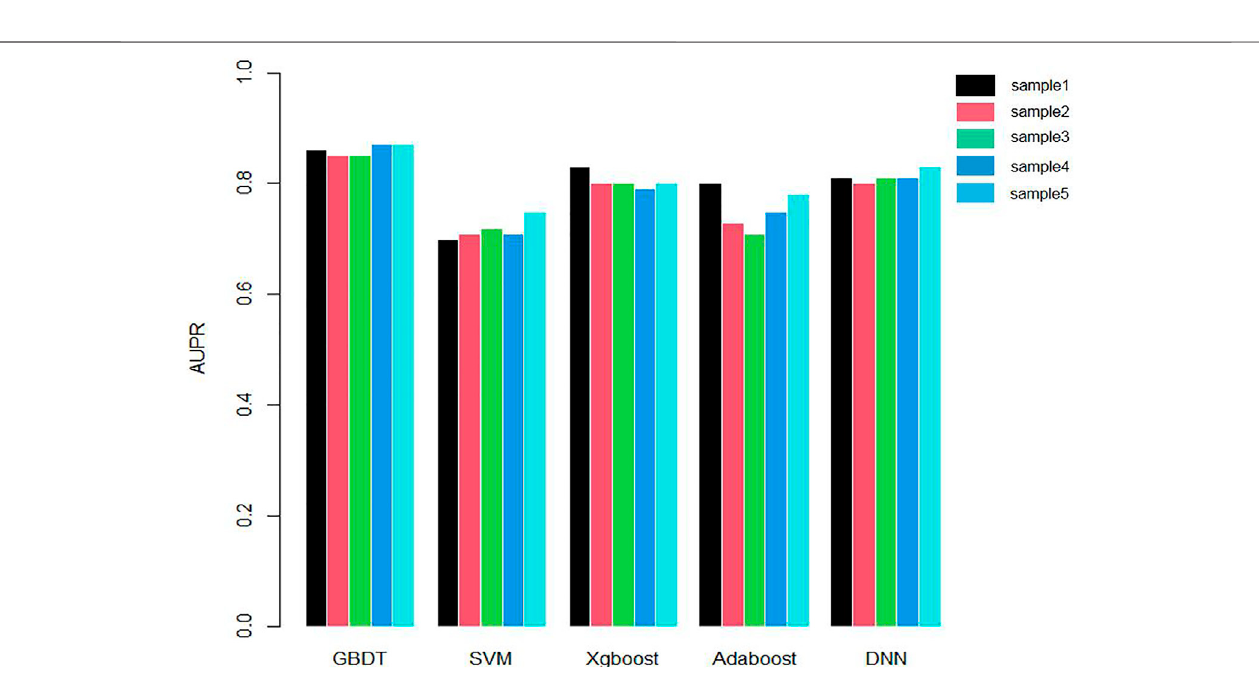
FIGURE 4 | Comparison chart of AUPR values of fi ve methods.